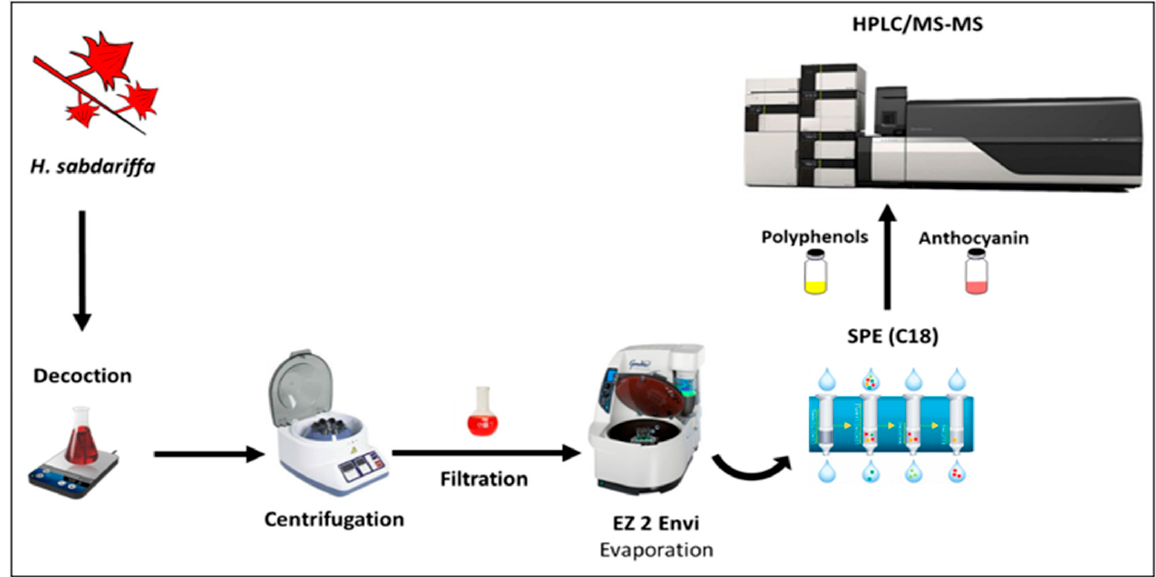
Figure 1. The extraction procedure of H.s. dried calyces and its analysis by liquid chromatography.